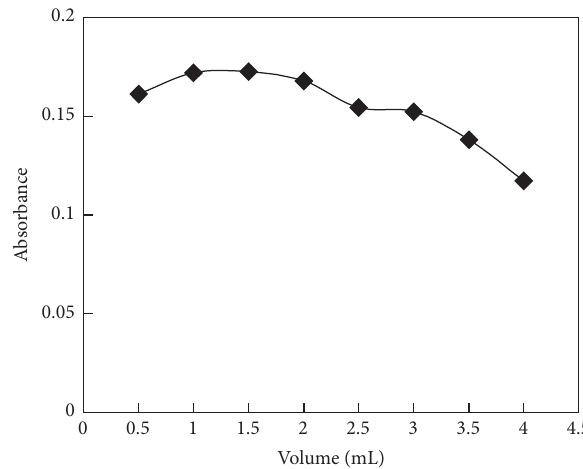
F 3: Effect of the amount of buffer solution on the absorbance